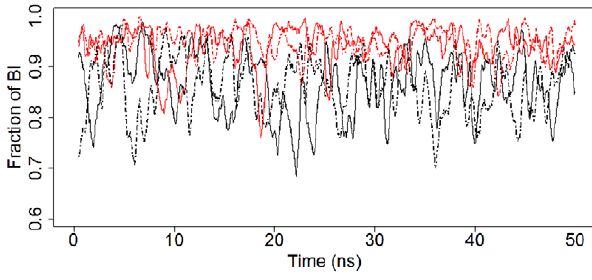
are shown as a function of time; black , unmethylated B-DNA; red , methylated 5mCB-DNA; solid and dashed lines , two independent 50 ns simulations. The plots are smoothed using a 500 ps sliding window.